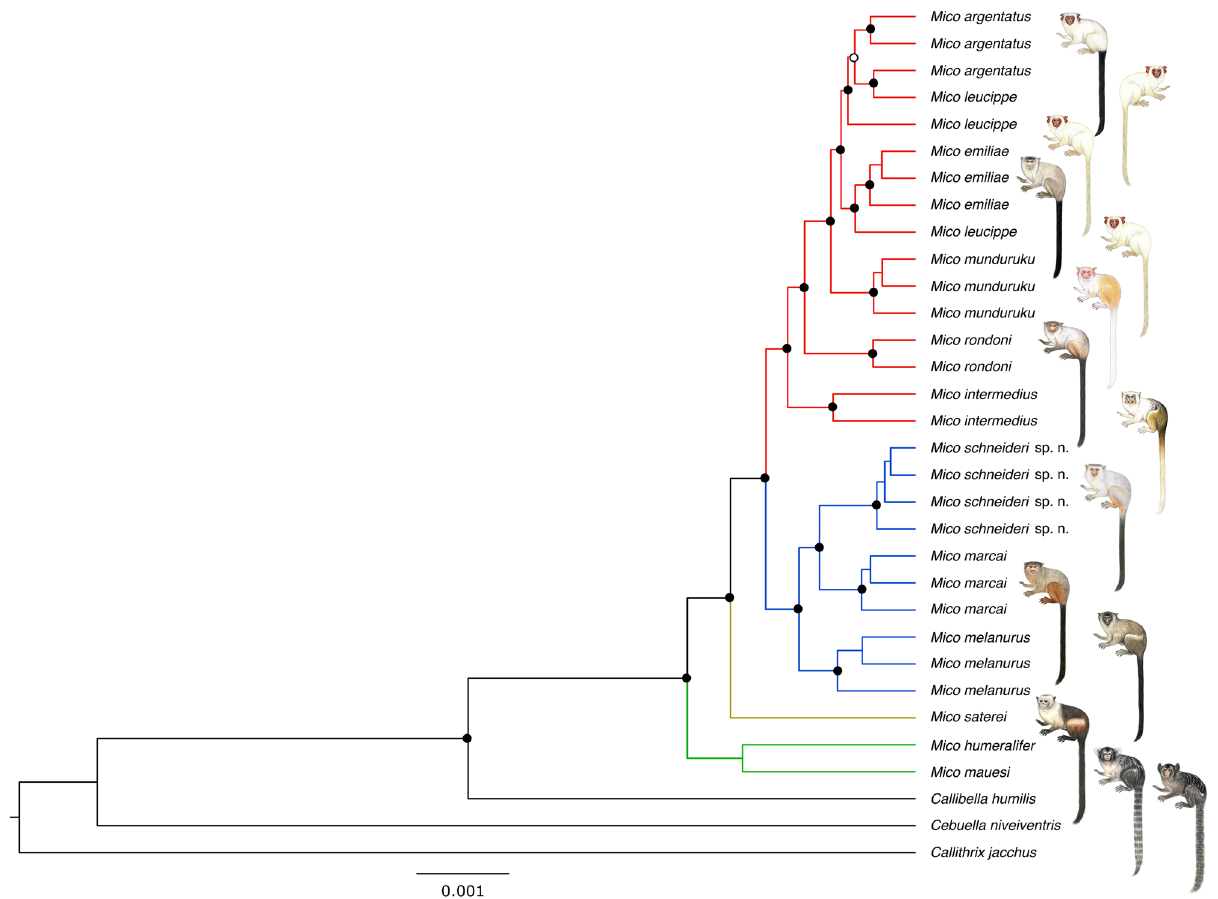
unresolved branches (≤ 0.95 posterior probability) by white circles. Illustrations: Stephen